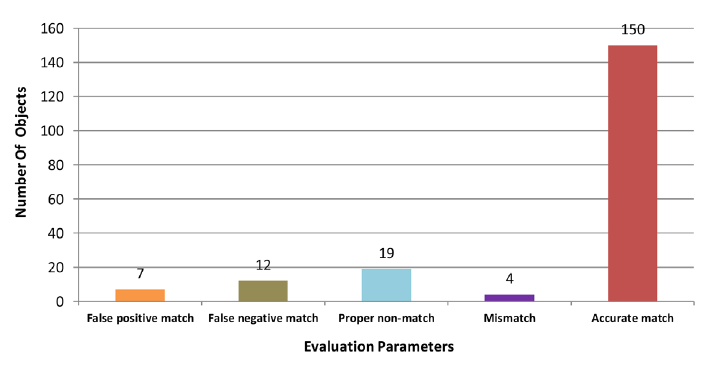
Fig. 21. Results obtained from evaluation